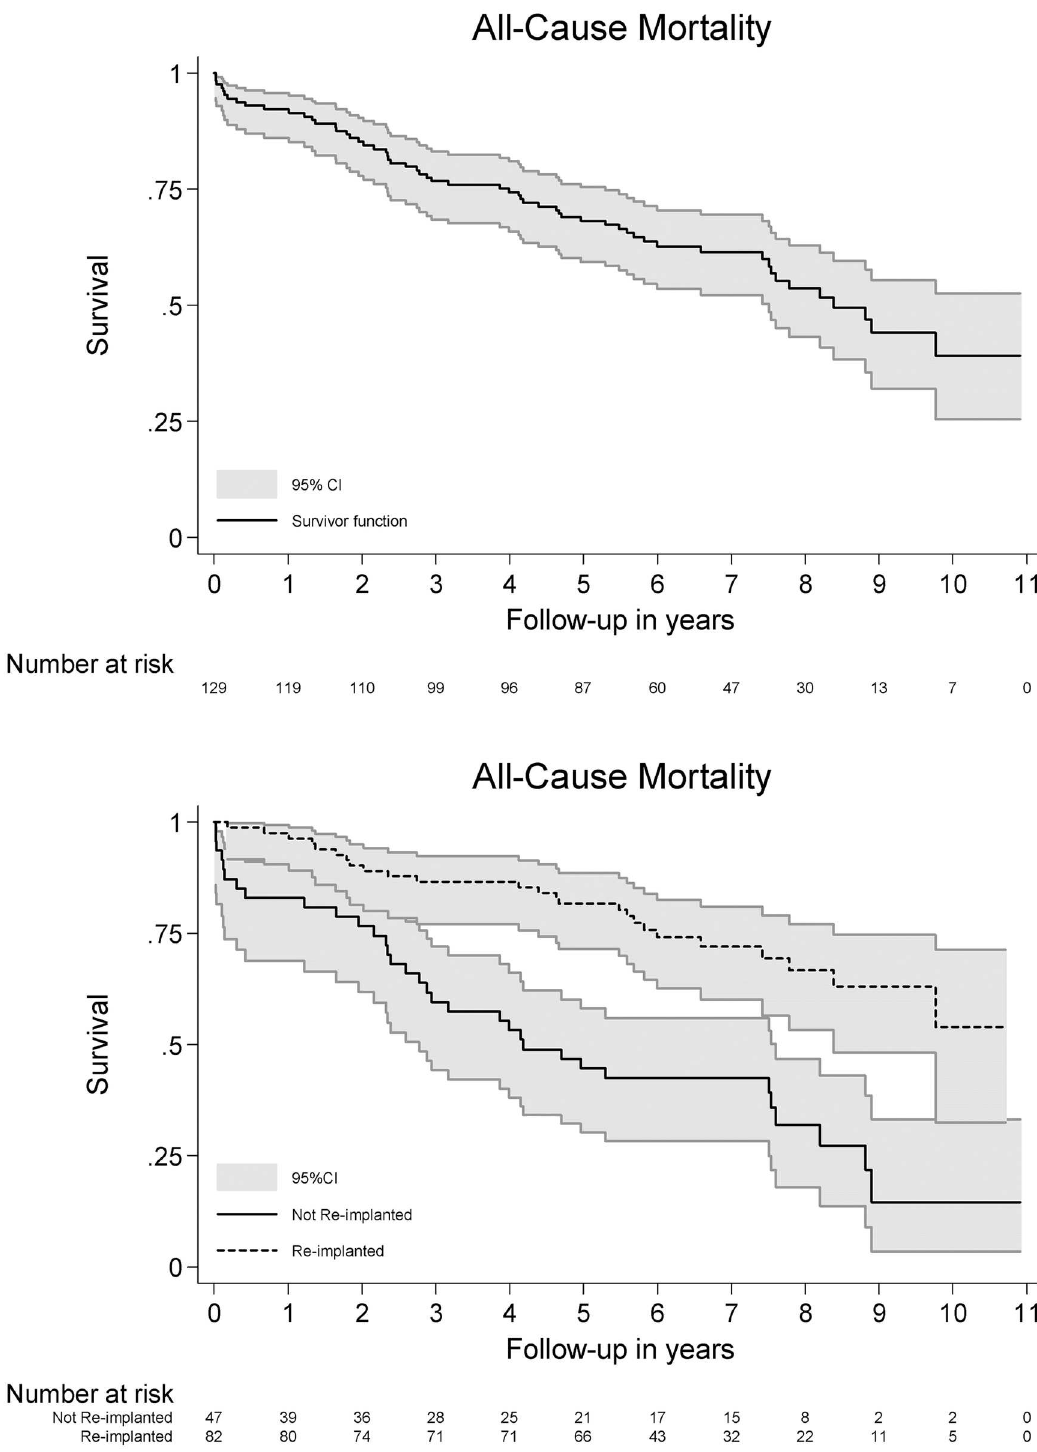
Fig 3. Mortality. Survival curve after treatment for chronic periprosthetic hip joint infection in 130 patients (upper). Survival curves after treatment for chronic periprosthetic hip joint infection in 81 patients undergoing re-implantation followinga two-stage revision strategy and 48 patients not undergoing re-implantation followinga two-stage revision strategy (lower).